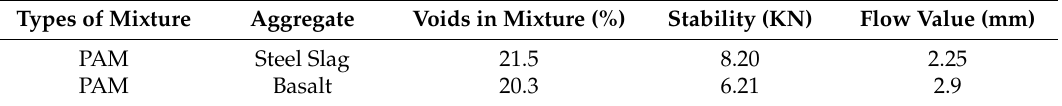
Table 6. Marshall stability